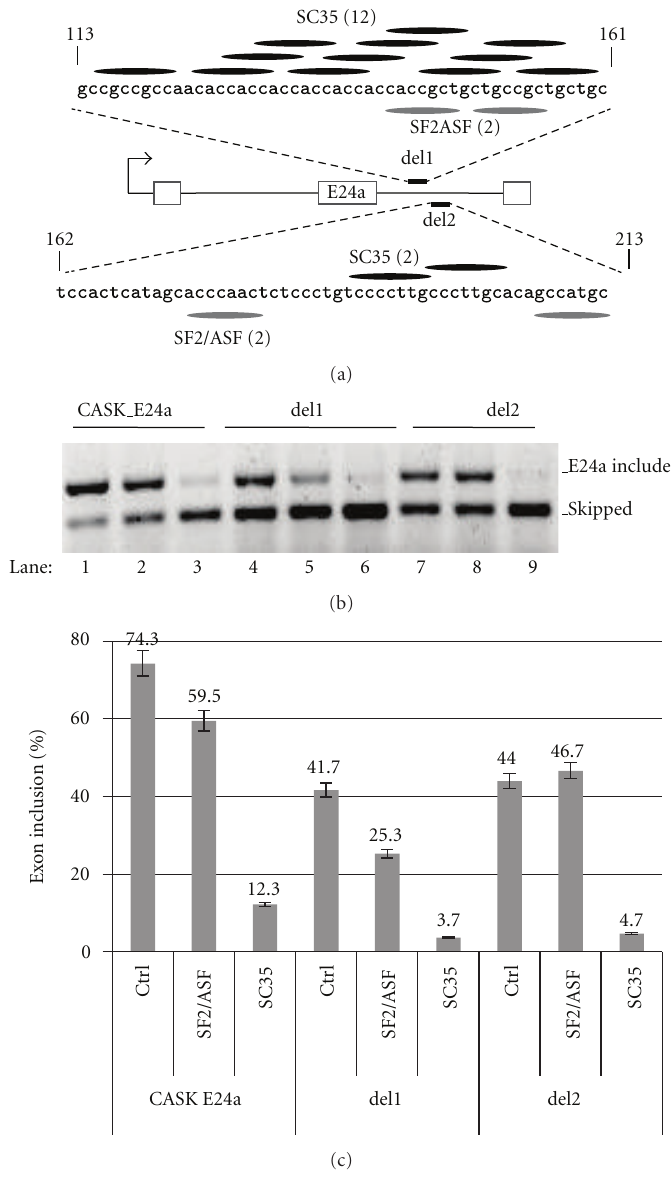
Figure 6: The splicing silencing roles of SC35 and ASF/SF2 are di ff erentially a ff ected by the deletion of cognate motifs in the downstream intron. (a) Schematic indicates structure of parent reporter, CASK E24a, and derivatives, del1 and del2. The deleted sequences are shown above and below the schematic, where nucleotide positions specify the boundaries of each deletion relative to the beginning of the intron. SC35 motifs, black ovals; ASF/SF2, grey ovals. The copy number of motifs in each deleted region is indicated in parentheses. (b) Gel panel displays exon included and skipped products measured by RT-PCR from N18TG2 transfections. Splicing reporters were cotransfected with ASF/SF2 (lanes 2, 5, 8) or SC35 (lanes 3, 6, 9) expression vector. Control samples (ctrl) received empty vector plasmid (lanes 1, 4, 7). (c) Bar graph illustrates the % exon inclusion values for the gel panel above. Error bars represent standard deviations.